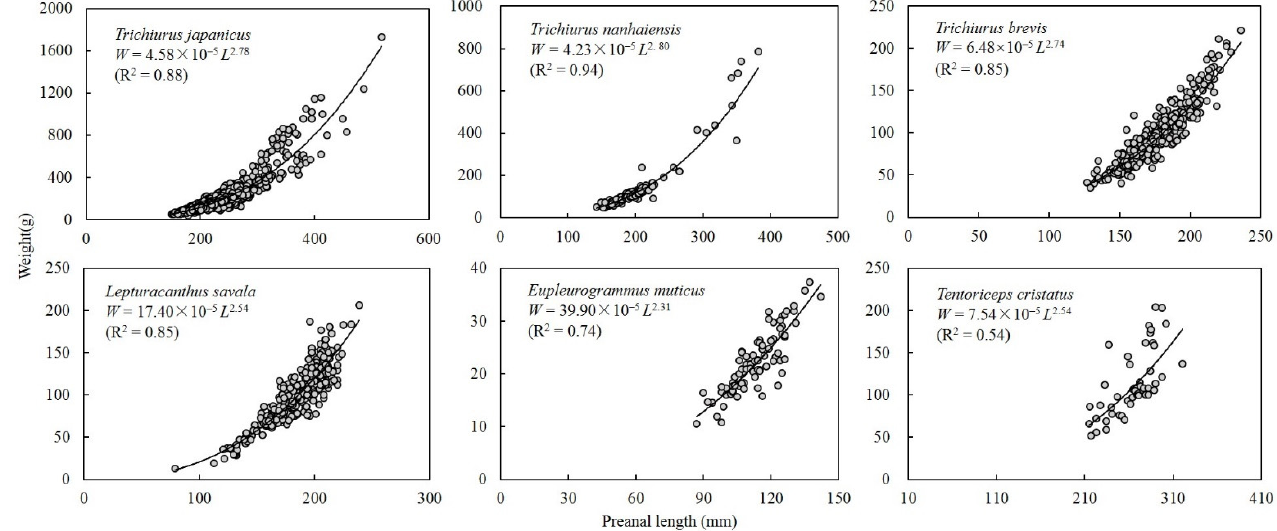
Figure 3. Relationship between preanal length and body weight in six species of Trichiuridae in Chinese seas.